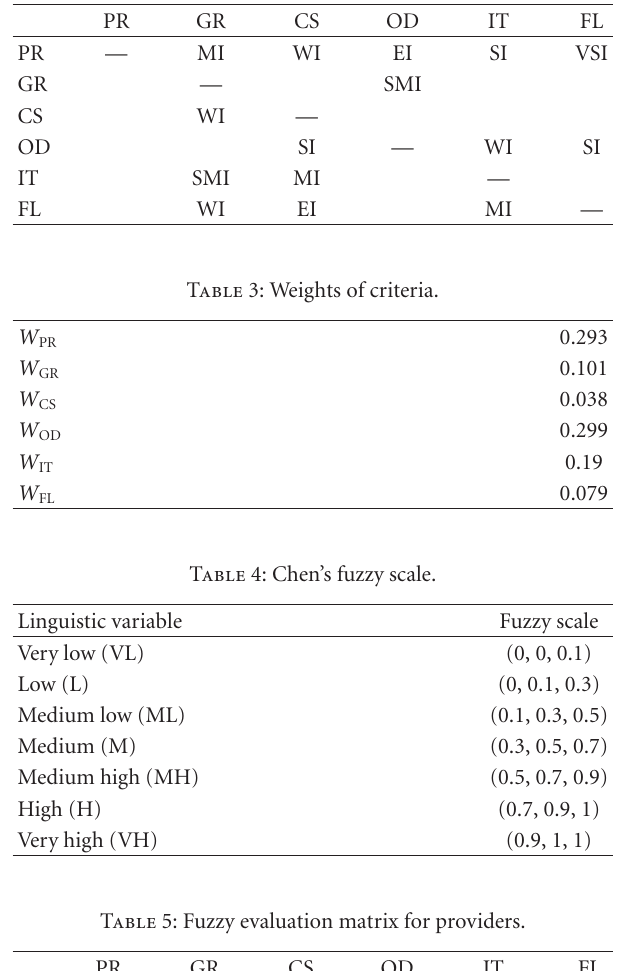
Table 2: The pairwise comparison matrix of criteria.